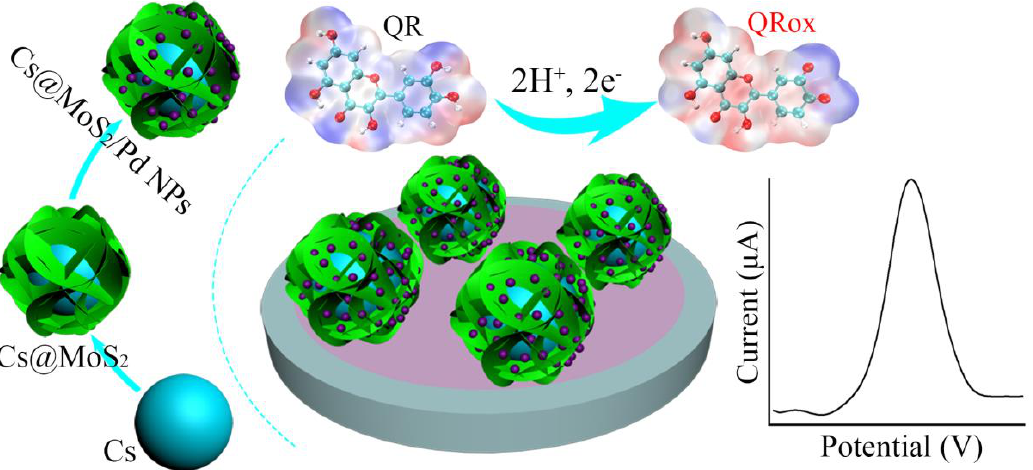
Figure 1. Schematic of the preparation of Cs@MoS 2 -Pd NPs and fabrication of the electrochemistry sensor.